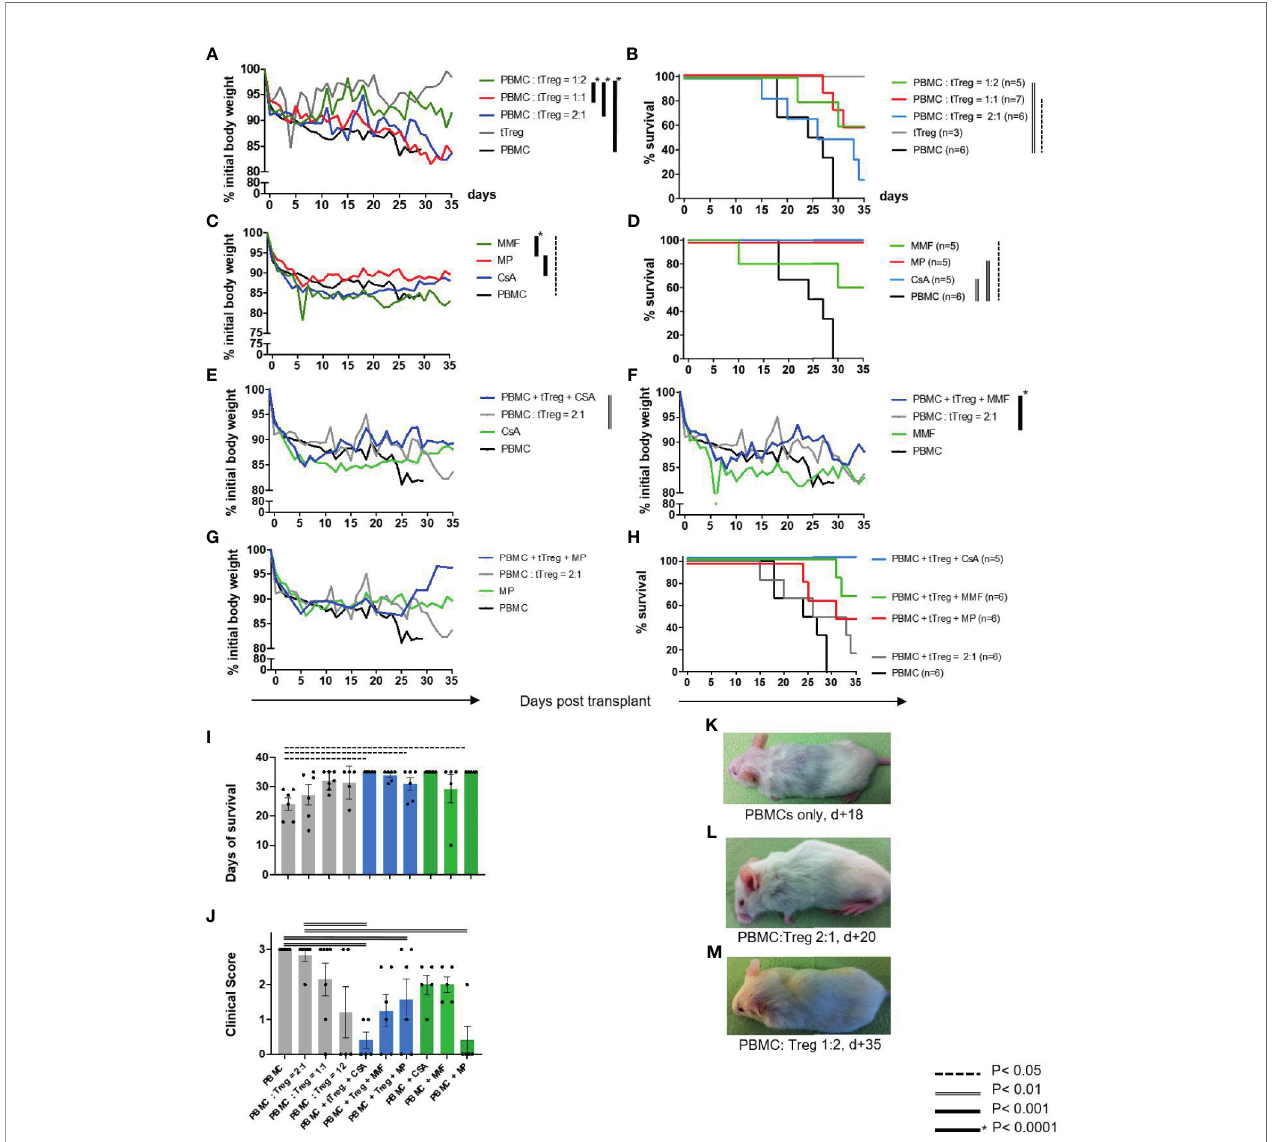
FIGURE 2 | Clinical course and survival rates. As described in Figure 1 GvHD was induced in NOD/SCID/IL-2Rgamma -/- mice by infusion of 3x10 6 human PBMC [GvHD control, (A – M) ]. tTreg control mice received ex vivo expanded human tTreg alone (3x10 6 ) but no PBMCs [tTreg, (A, B) ]. (A, B) Mice were treated with